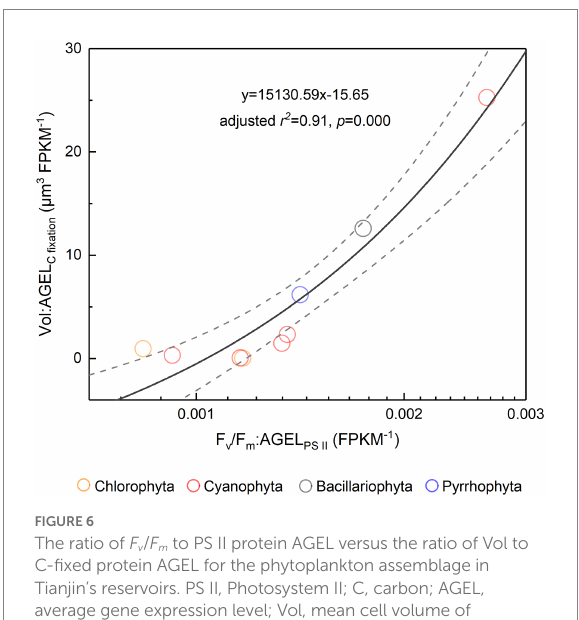
FIGURE 6 The ratio of F v / F m to PS II protein AGEL versus the ratio of Vol to C-fixed protein AGEL for the phytoplankton assemblage in Tianjin’s reservoirs. PS II, Photosystem II; C, carbon; AGEL, average gene expression level; Vol, mean cell volume of phytoplankton assemblage. Different color point represents different dominant algal group in each sampling site. The dotted lines represent the 95% confidence